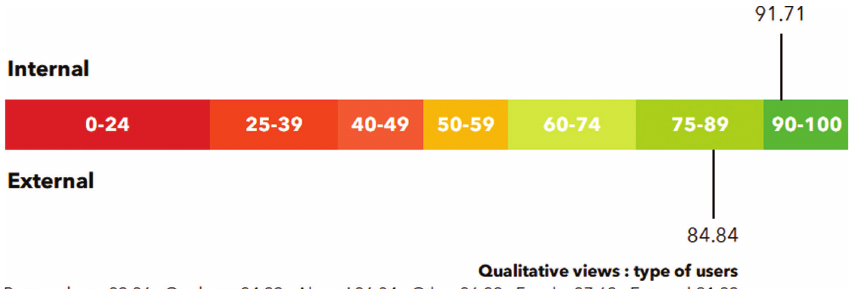
Fig. 3: Patron Service